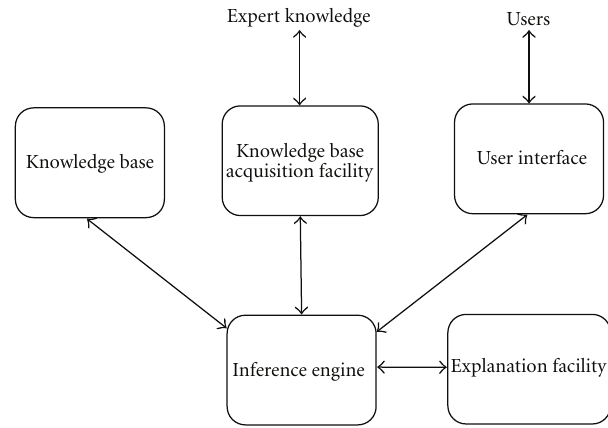
Figure 1: Architecture of a simple expert system [16].